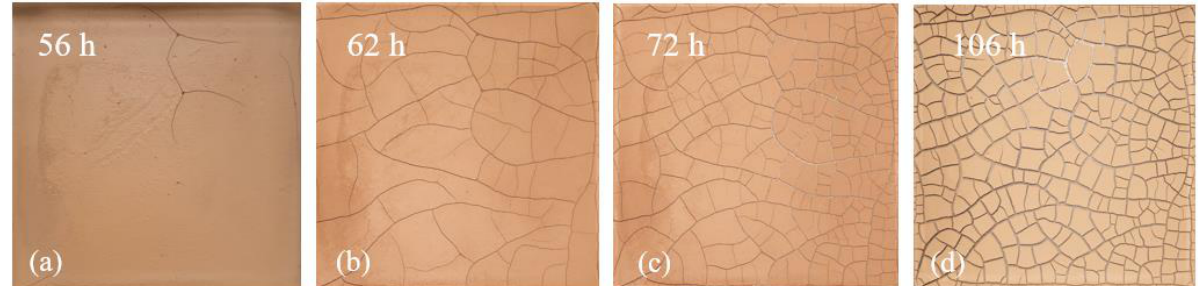
Figure 5. Characteristics of soil fissure development without root system. ( a ) Cracks appear; ( b ) Main fissure formation; ( c ) Secondary fissure formation; ( d ) Fissure extension.